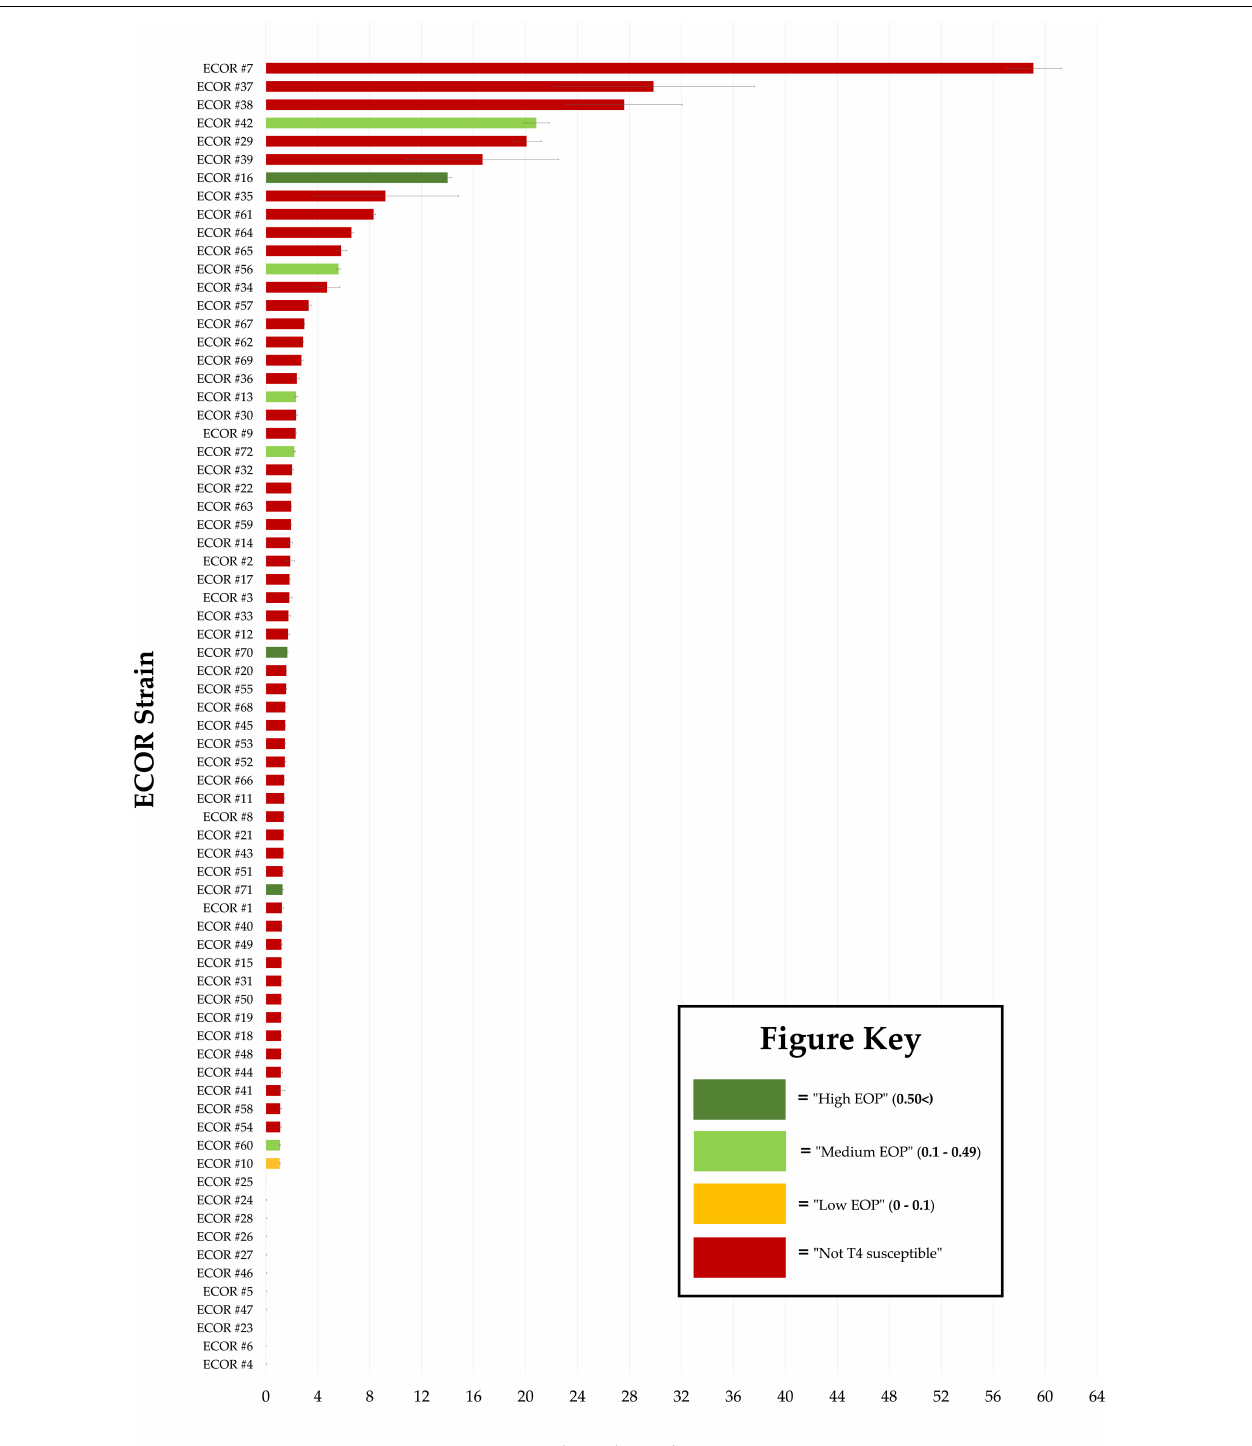
Frontiers in Microbiology |